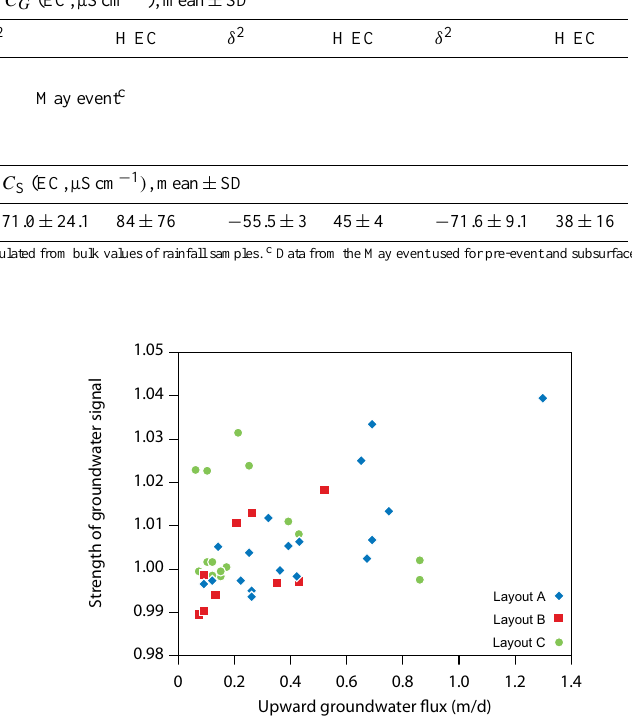
Figure 5. Correlation of the strength of the groundwater signal as recorded by DTS with upward groundwater fluxes estimated from VTPs. Measurements from each layout are separated by